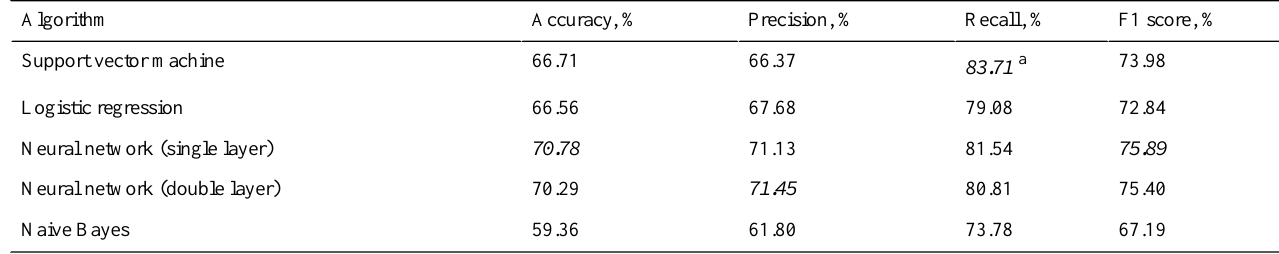
Table 6. Classification results for the second set of data.